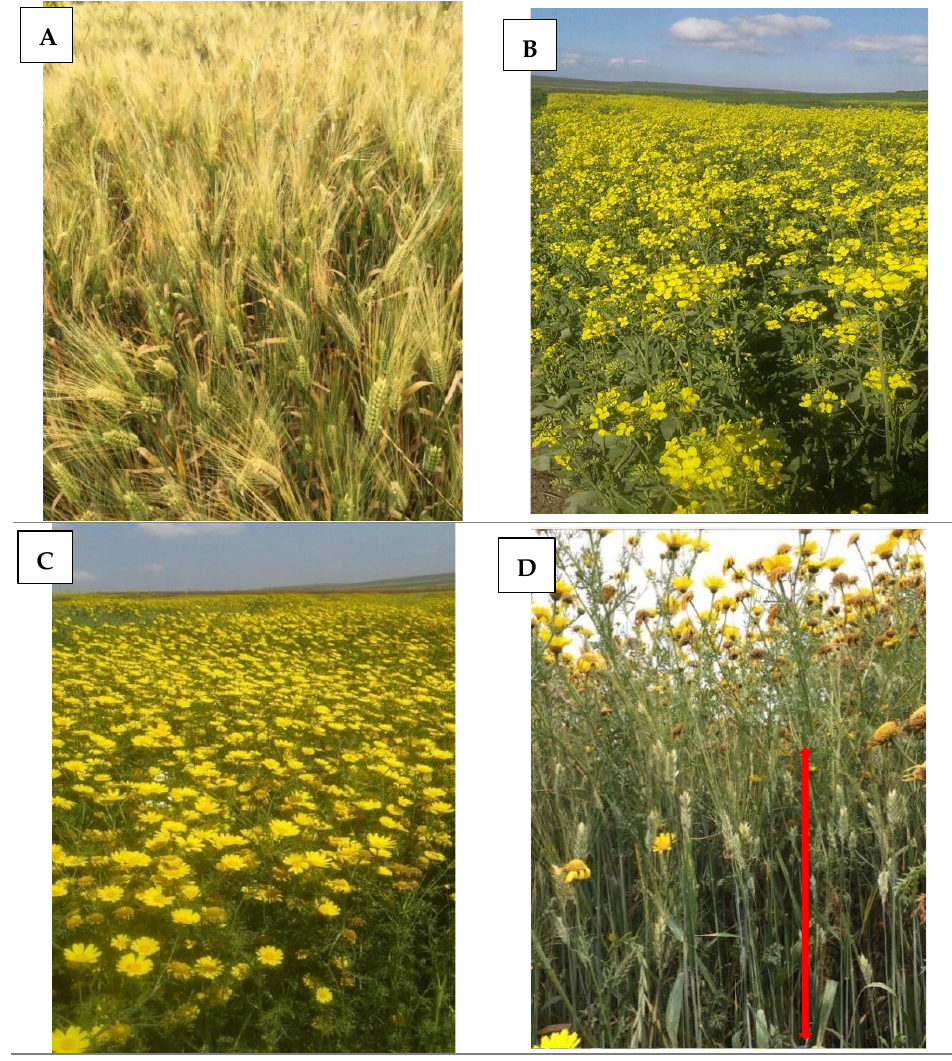
Figure 7. G. coronaria infestations under different crops compared to the non-cultivated plot at flowering stage, ( A ): herbicide-treated plot of barley; ( B ): herbicide-treated plot of rapeseed; ( C ): non-cultivated plot; ( D ): non-treated plot of wheat; Red arrow showed the height of wheat in non-treated plot.